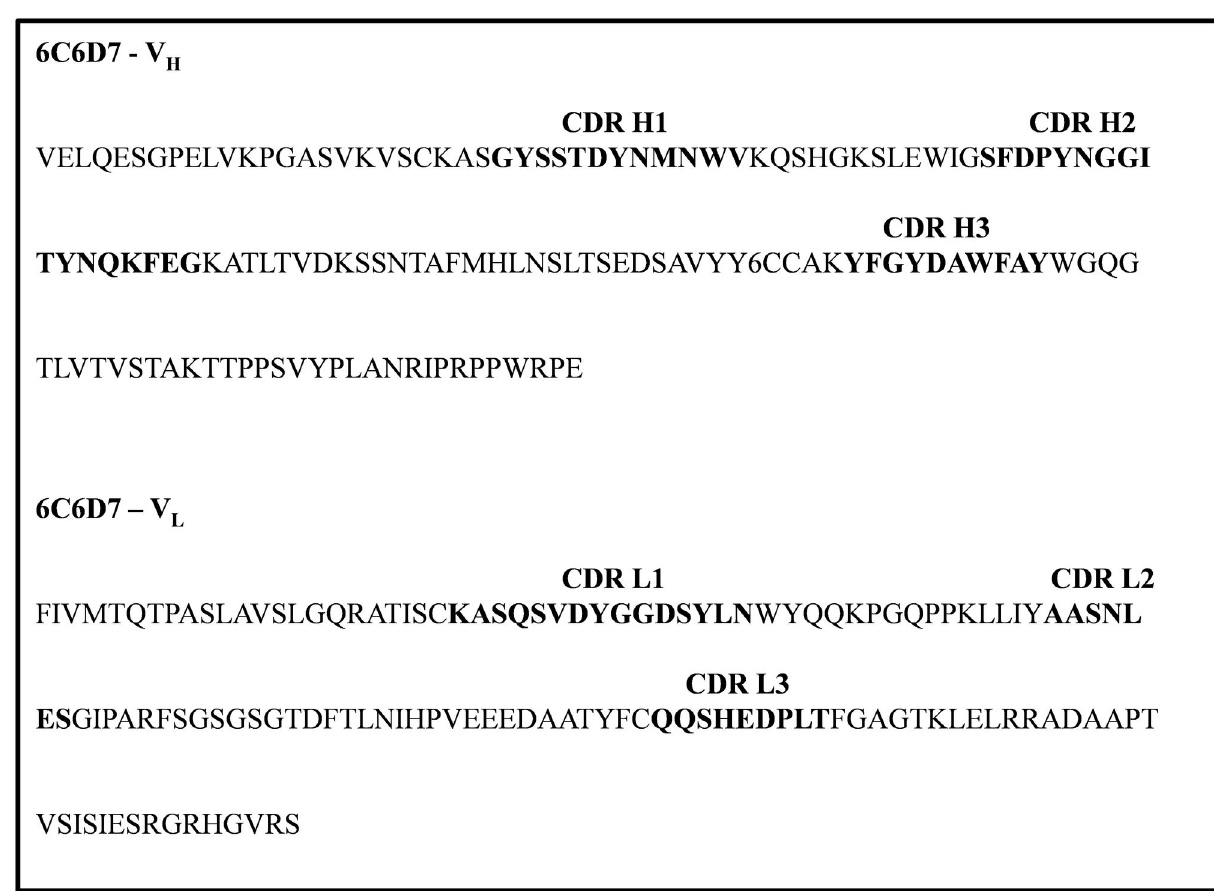
Figure 2. Sequencing of 6C6D7 light and heavy chain variable regions. Amino acid sequence of 6C6D7 light and heavy chain variable regions are shown with CDRs marked. The CDRs were determined from the gene sequence using IMGT database and IgG